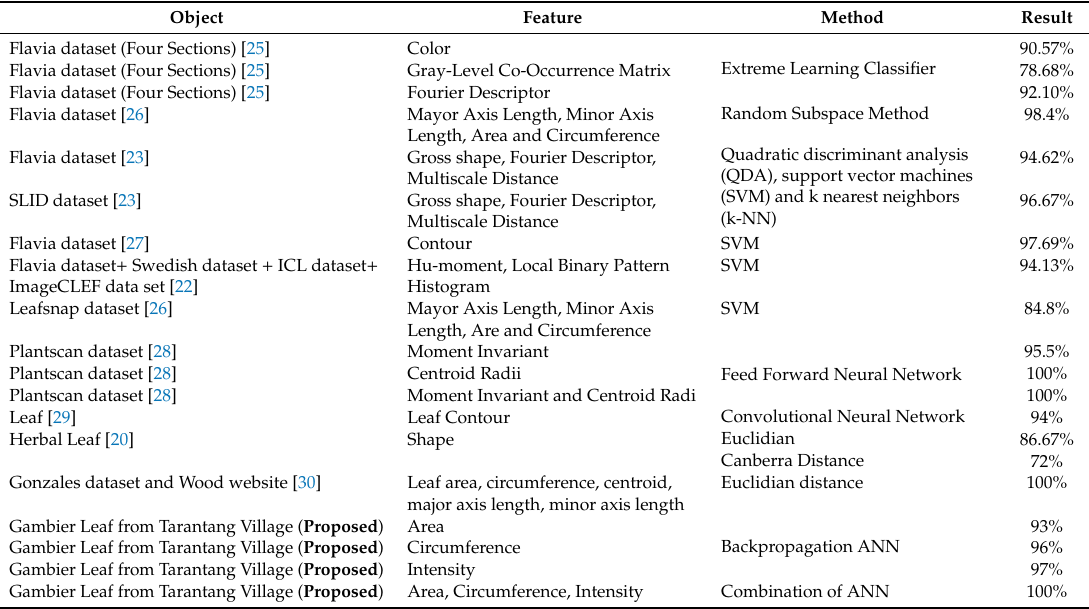
Table 17. Result of comparisons with the purposed